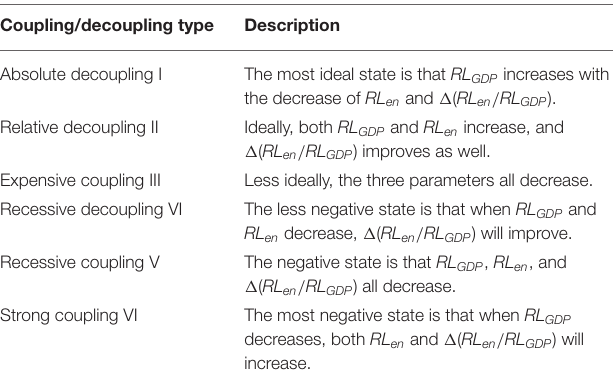
TABLE 1 | Meanings of each coupling/decoupling